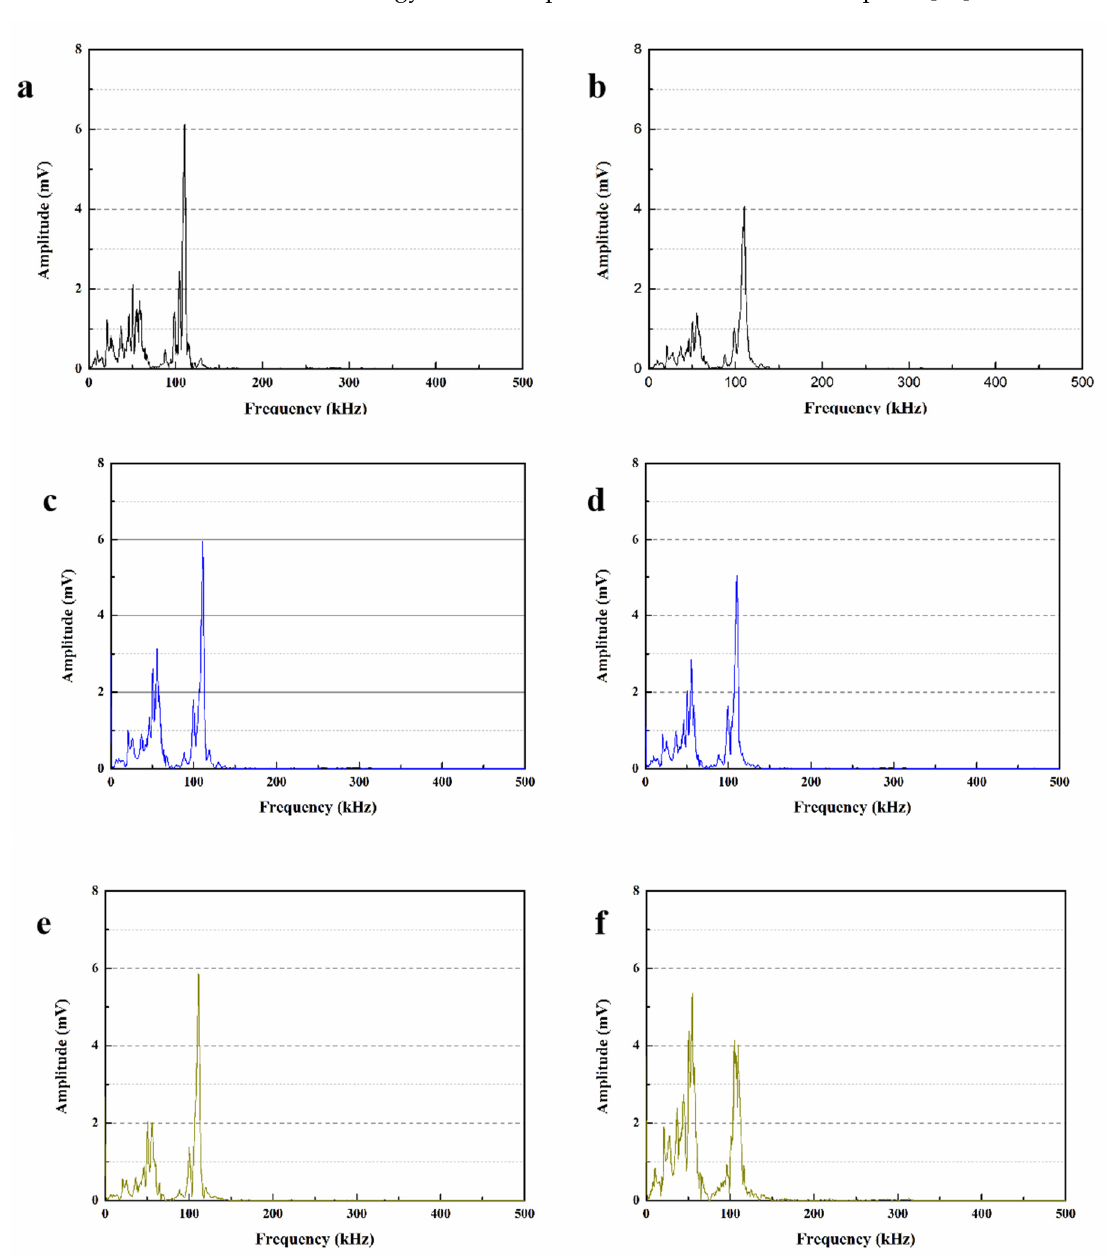
Figure 13. Ultrasonic frequency of mortars. ( a ) initial maximum amplitudes of the dominant frequency of SJ-0, ( b ) maximum amplitudes of the dominant frequency of self-repaired SJ-0, ( c ) initial maximum amplitudes of the dominant frequency of SJ-1, ( d ) maximum amplitudes of the dominant frequency of self-repaired SJ-1, ( e ) initial maximum amplitudes of the dominant frequency of SJ-2, ( f ) maximum amplitudes of the dominant frequency of self-repaired SJ-2.